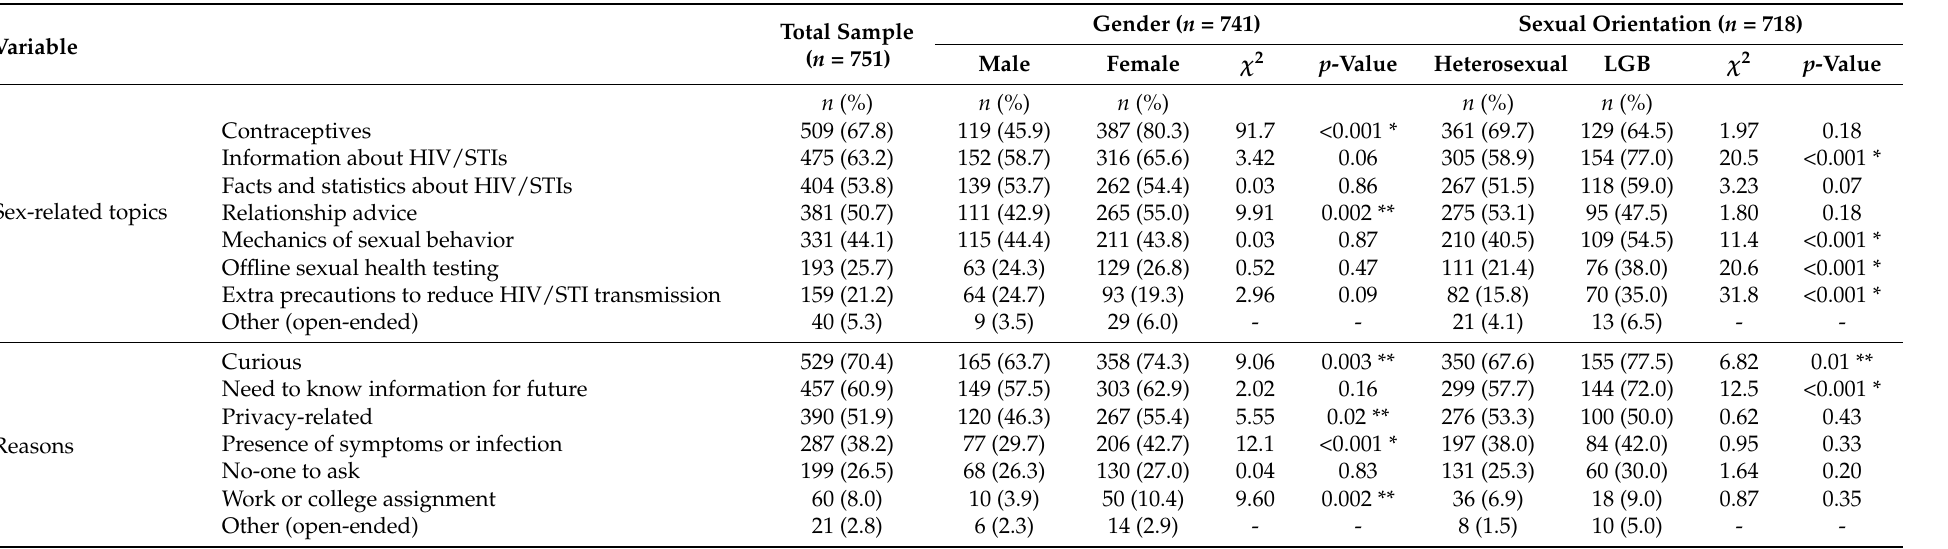
Table 3. Frequencies of sex-related topics searched for and reasons for conducting searches, accounted for by gender and sexual